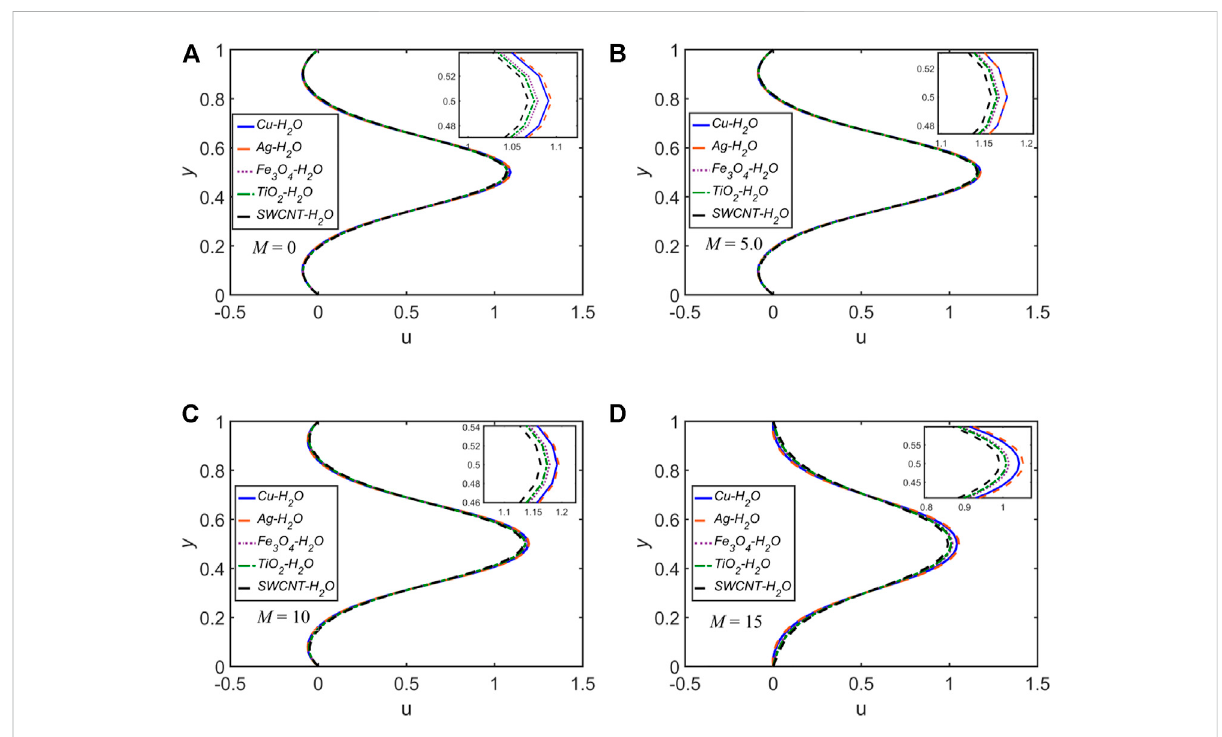
The velocity pro fi le u versus y at x (cid:2) 2 and t (cid:2) 0 . 25 for the fi ve NFs for distinct values of M